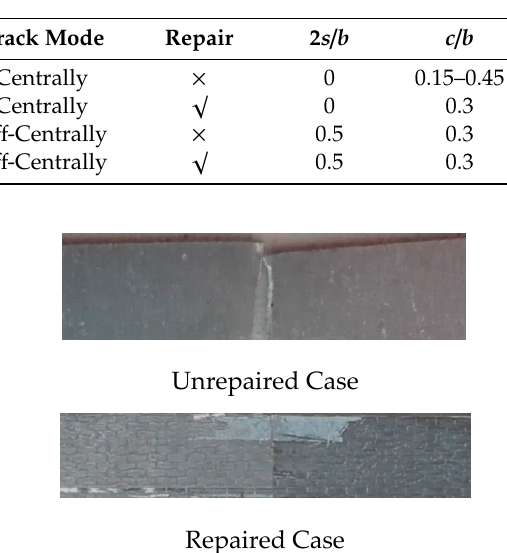
Table 2. List of test specimens.